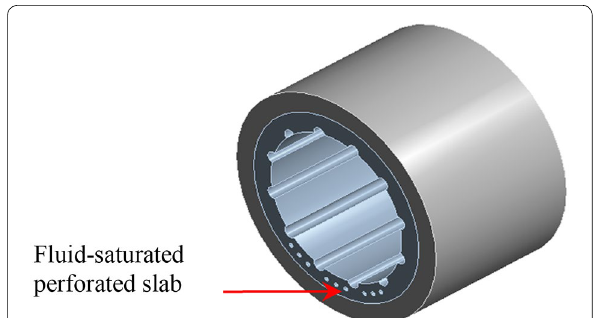
Figure 2 Damping-enhanced water-lubricated